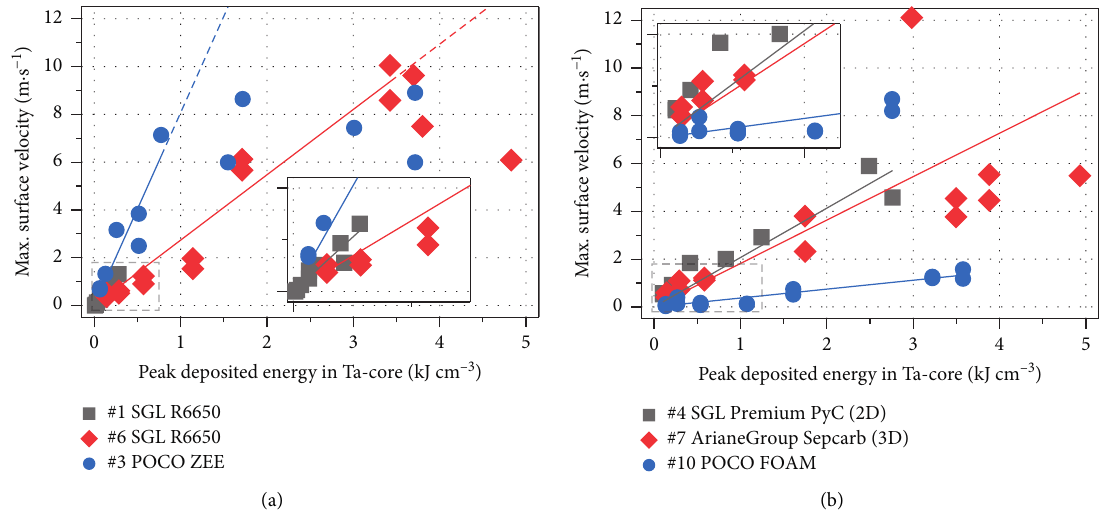
Figure 19: Recorded maximum surface velocity. Absolute maximum surface velocity (symbols) as a function of deposited energy in the tantalum core for targets #1, #3, and #6 (a) and targets #4, #7, and #10 (b). Insets are blow-ups of the dashed boxes. Lines represent a guide to the eye for the proposed range of deposited energy where the sample shows an overall elastic response. Error bars are smaller than the